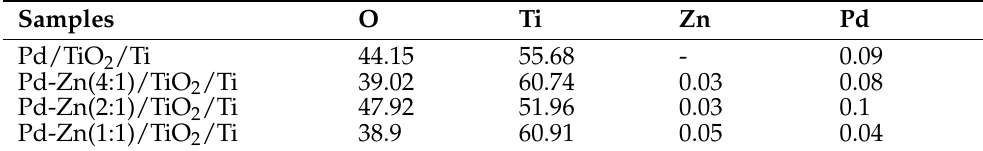
Table 3. SEM-EDS analysis of the amounts of Pd and Zn in wire catalysts [wt.%].